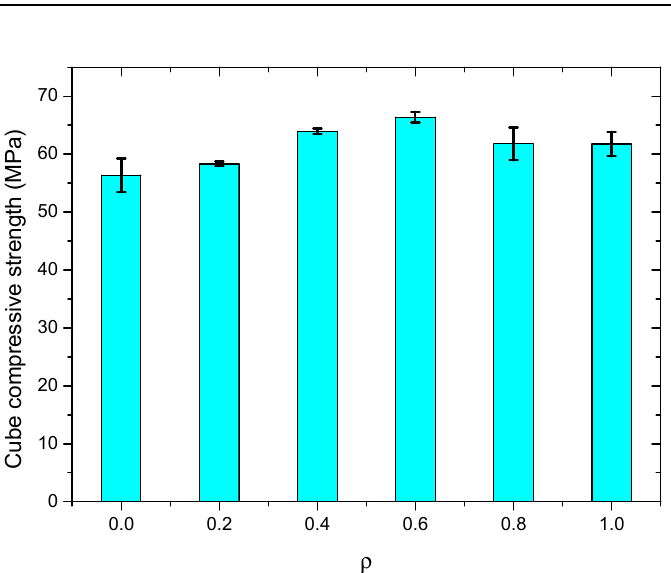
Figure 10. Comparison between numerical and test results: f cu . Figure 11. Comparison of compressive strength between POM-SWSSC and other types of fi- ber-reinforced concrete [58–61].